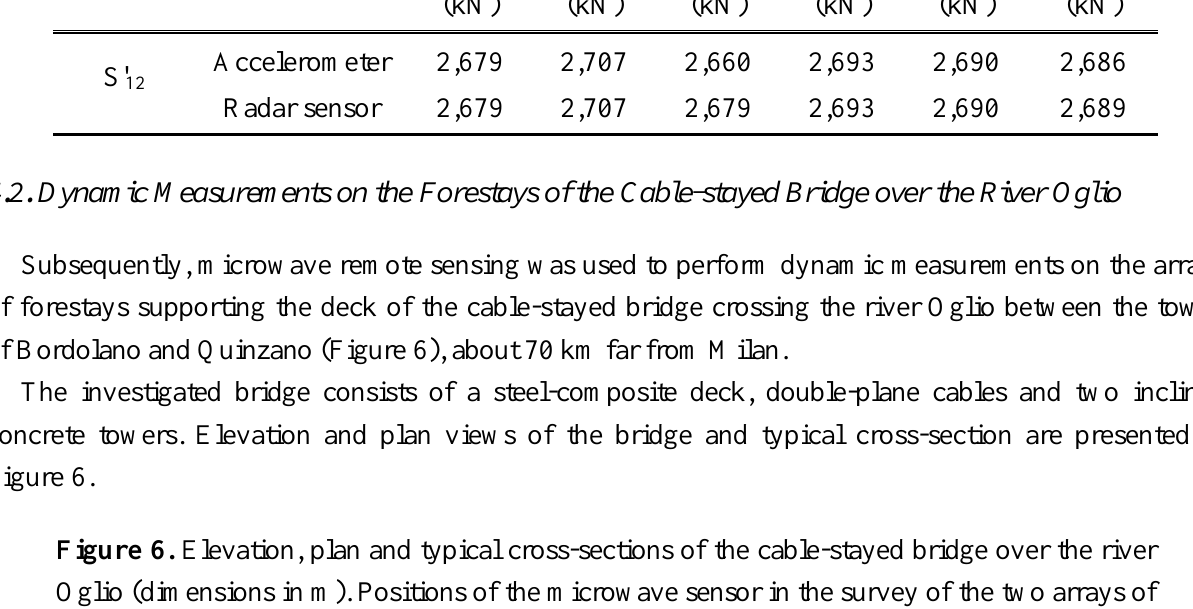
Table 1. Tensions in cable S'